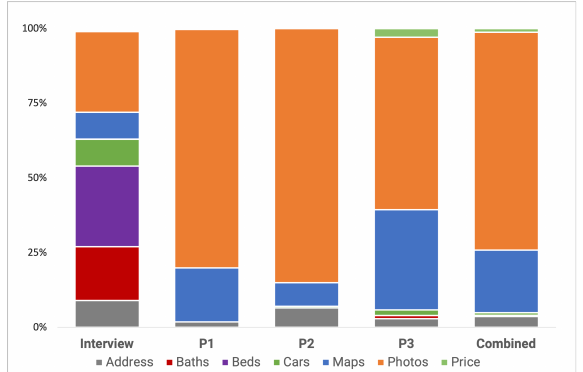
Figure 4. The percentage of time spent by participants on different Area of Interests in the listing compared to their corresponding proportion of interview